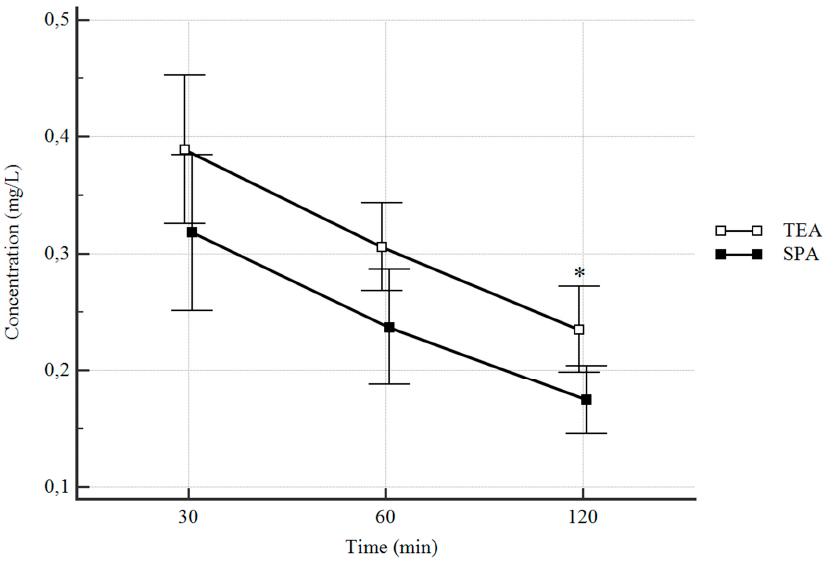
Figure 3. Levobupivacaine serum concentration-time course after epidural and subpleural paravertebral administration. Data are presented as mean (95% CI). * Significantly different ( p < 0.05).